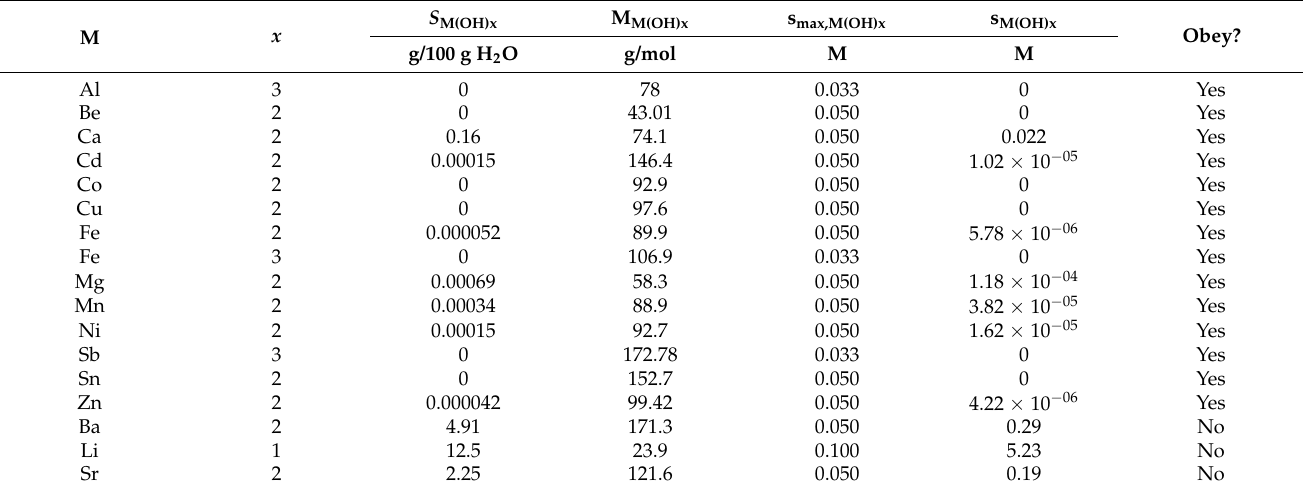
Table 4. The metal hydroxides that have low enough solubility in water at T = 293 K, i.e., obey condition III (among those that passed conditions I and